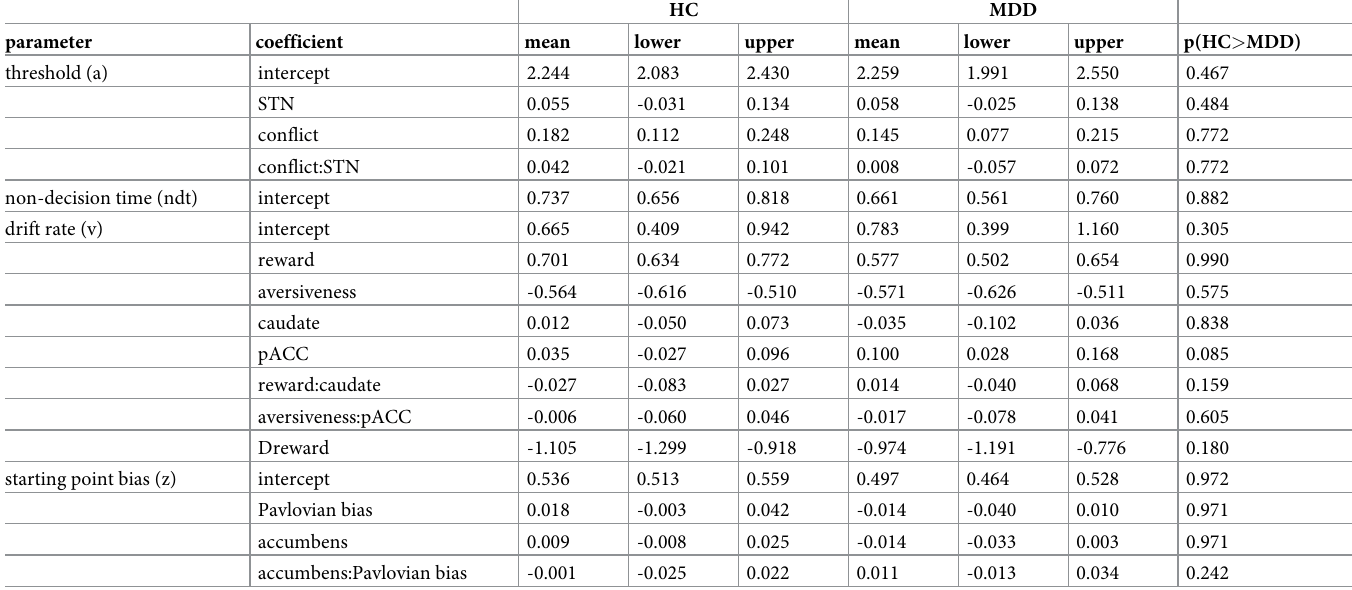
Table 1. Posterior distributions of group parameters. Lower and upper represent the lower and upper bound of the 95% highest density interval of the posterior